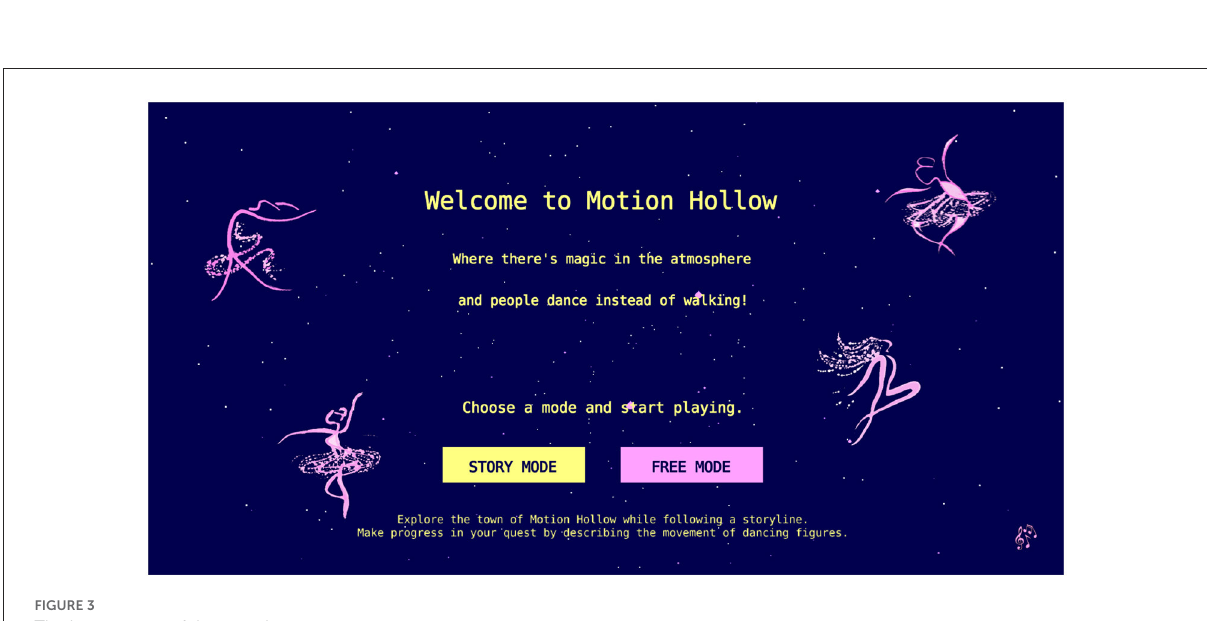
FIGURE3 The intro screen of the